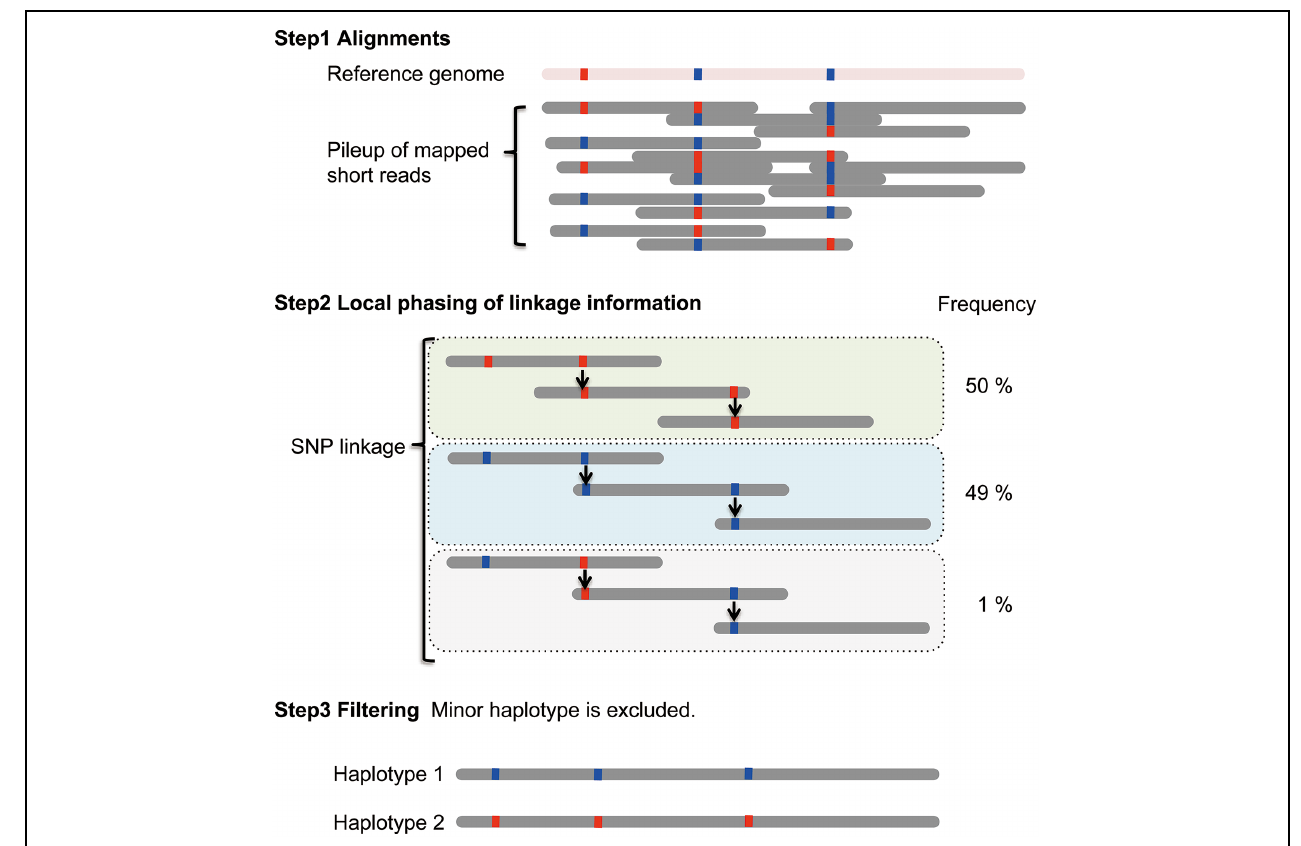
FIGURE 1 | Local haplotype reconstruction using the linkage method for a single diploid individual. Scheme was adapted from Sasaki et al. (2013).